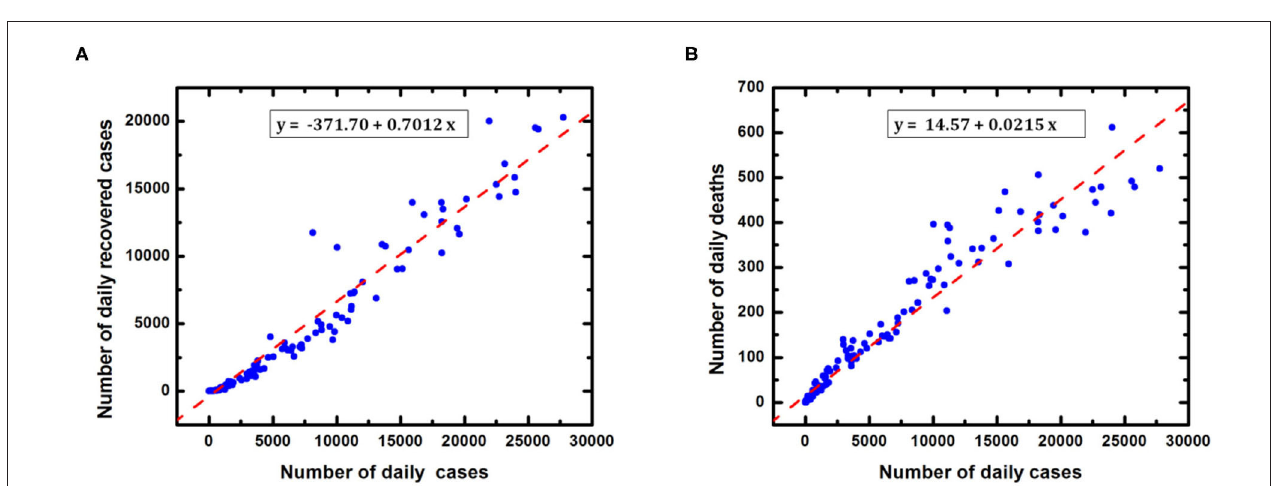
FIGURE 3 | Determination of recovery rate and death rate in India (A) Reported recovered cases (B) Reported deaths with respect to daily confirmed cases. The recovery rate ( γ ) and death rate ( δ ) have been estimated using linear regression method with r = 0.9701 and p < 0.0001.